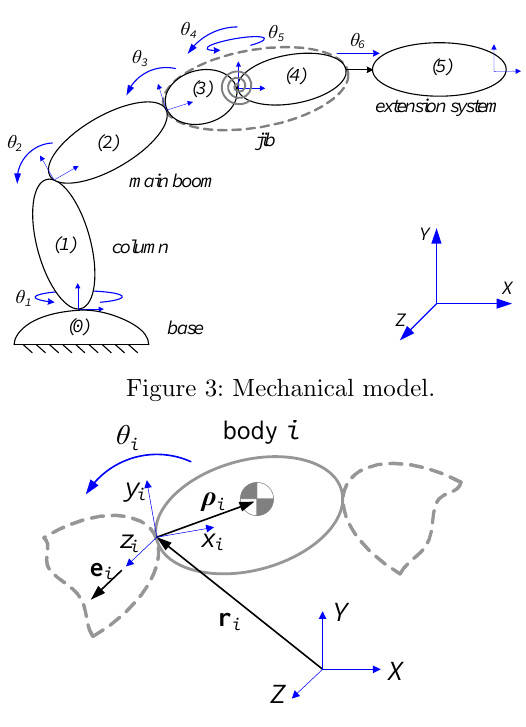
Figure 4: Joint and body definitions. of the